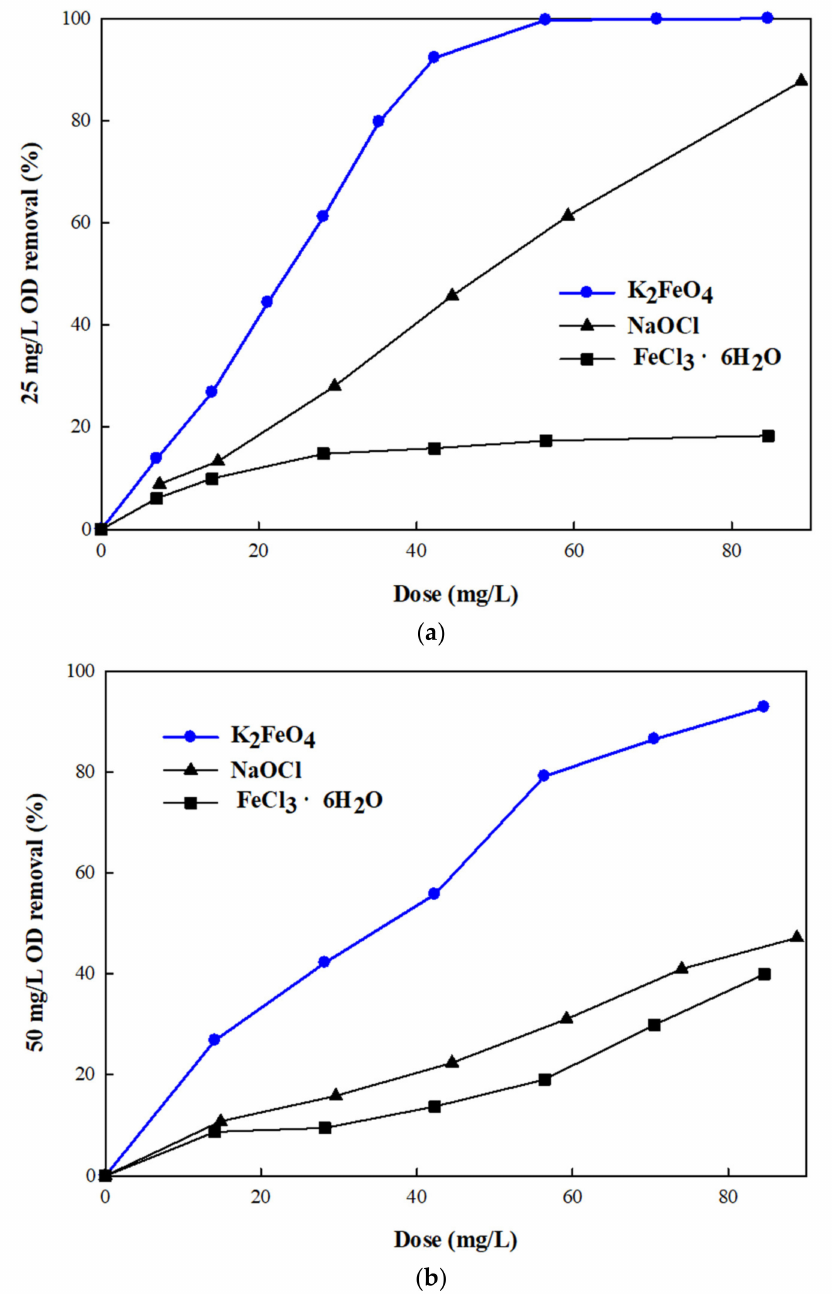
Figure 4. Comparison of potassium ferrate with NaOCl and FeCl 3 · 6H 2 O with respect to the removal efficiency of ( a ) 25 mg/L and ( b ) 50 mg/L of orange II azo dye at pH